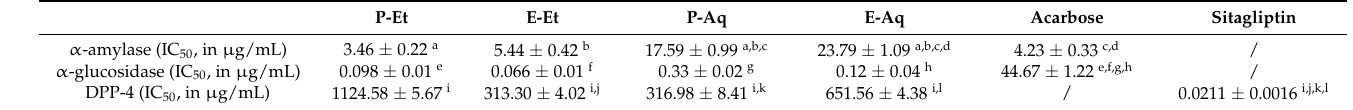
Table 5. The results of antihyperglycemic potential